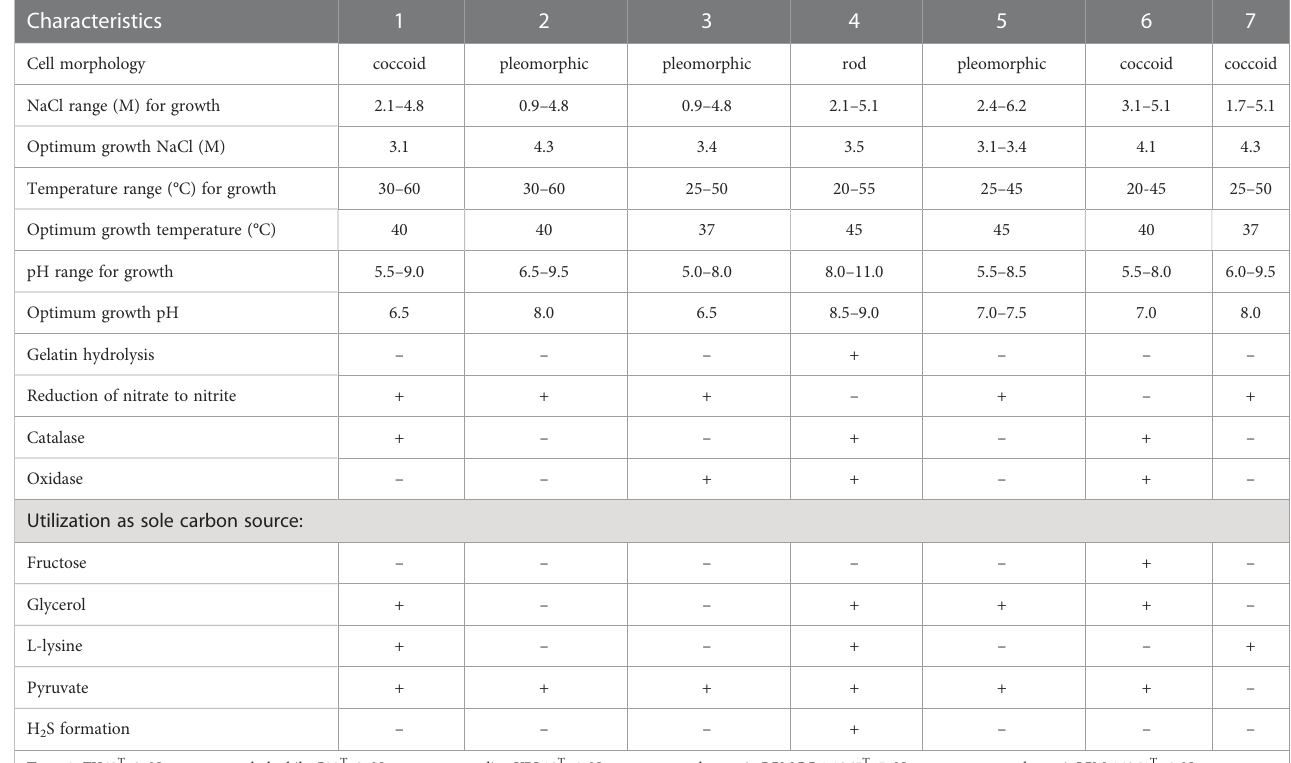
TABLE 2 Differential characteristics of strain ZY43 T and Natronomonas species.